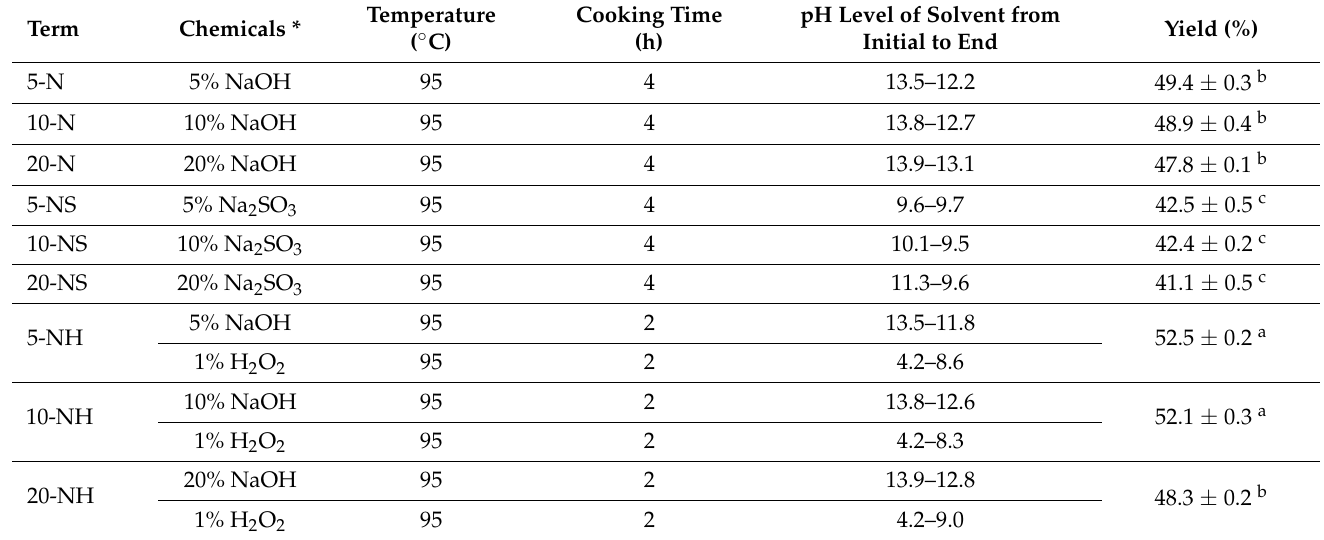
Table 1. Cooking conditions and solid yield of Rhizoclonium.